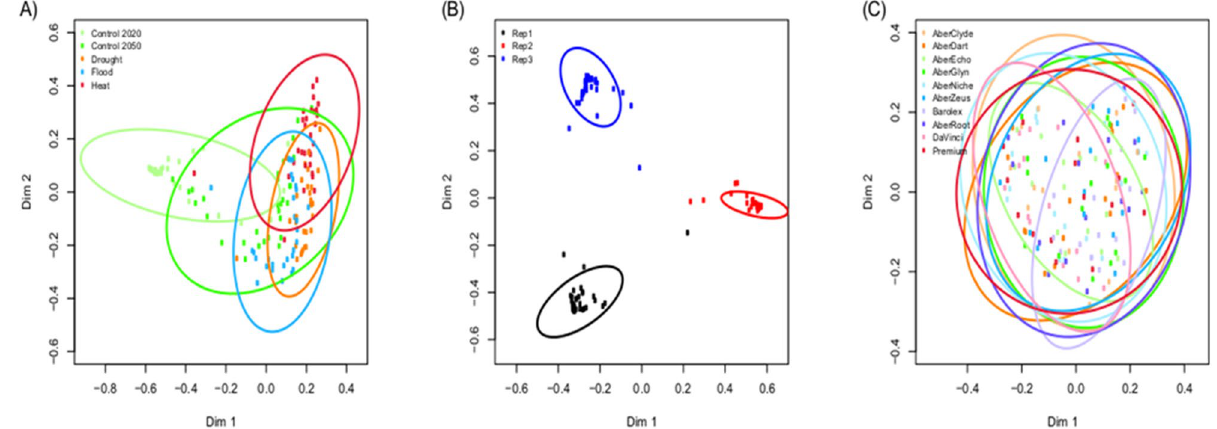
Figure 4. MDS ordination of VOC profiles of grass varieties exposed to rumen fluid, based on proximity values from random forest classification by ( A ) climate scenario; ( B ) biological replicate; and ( C ) variety of